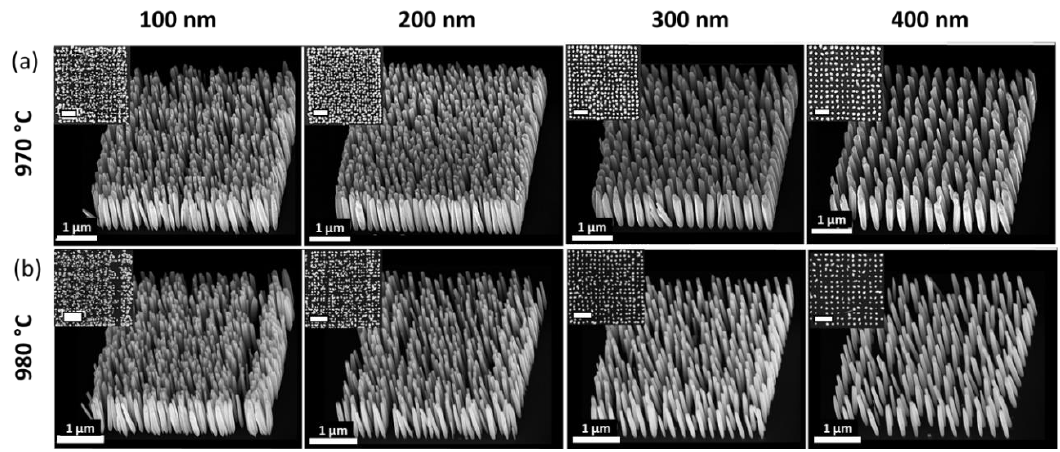
Figure 5. Bird’s-eye view SEM micrographs of the NRs grown at ( a ) 970 ◦ C and ( b ) 980 ◦ C on patterns with various pitches. The inset shows the top-view SEM image of the NRs. All scale bars correspond to 1 µm.